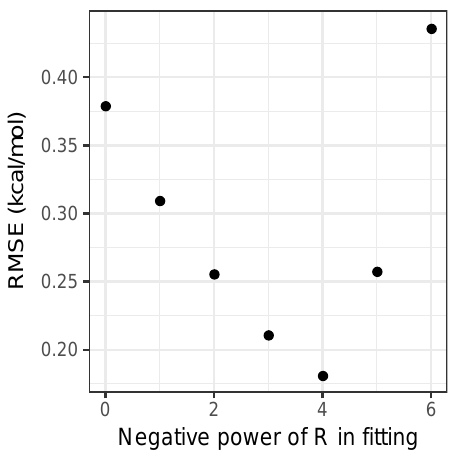
Figure 2. Root-mean-square error over the fitting set for the Pn models, as a function of n . While including a distance dependence clearly improves accuracy, it also introduces